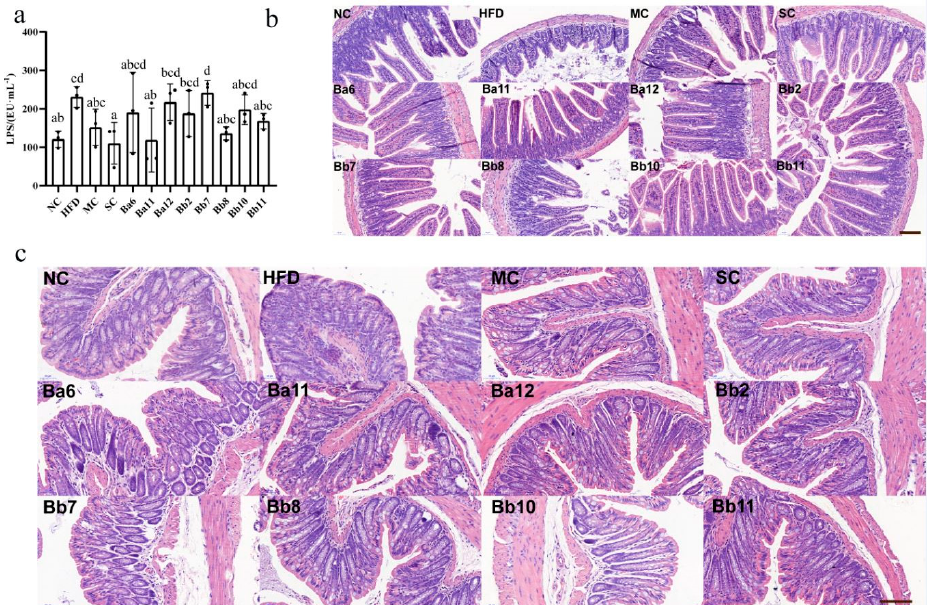
Figure 4. Effect of Bifidobacterium on intestinal permeability of NAFLD mice. ( a ), the concentration of serum LPS; ( b ), the ileal histopathology in NAFLD mice treated with different bifidobacteria; ( c ), the colon histopathology in NAFLD mice treated with different bifidobacterial. Scale bar = 100 μ m. Mean values with different letters (a–d) over the bars are significantly different ( p < 0.05) according to Duncan’s multiple range test.